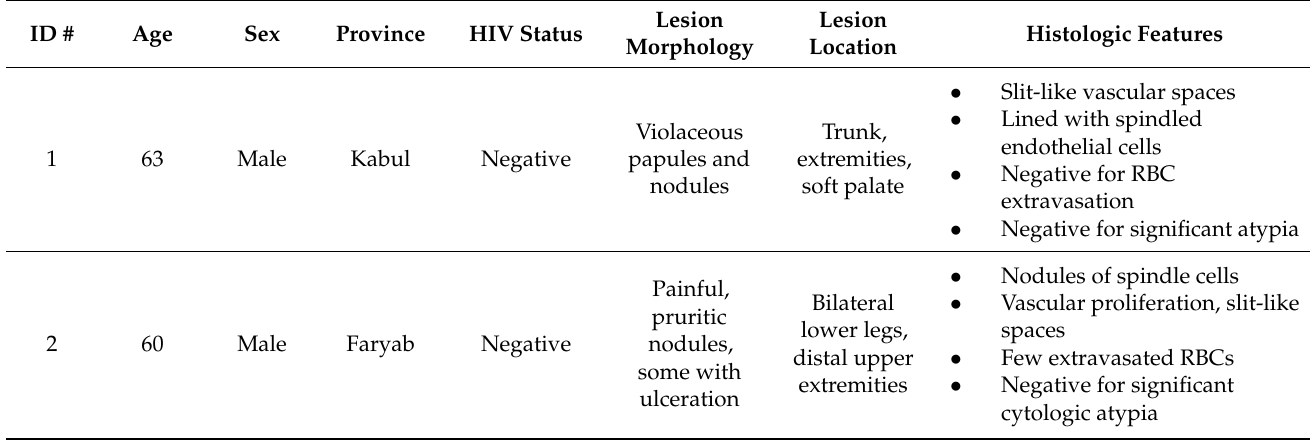
Table 1. Characteristics of patients with Kaposi